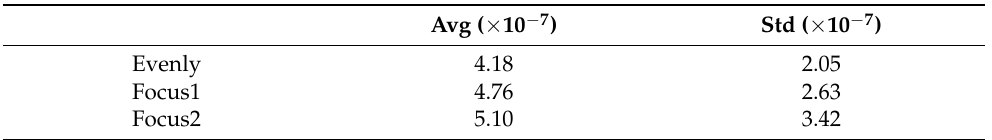
Figure 5. Sensitivity distribution of ( a ) uniform electrode array, ( b ) optimized array1 and ( c ) opti- mized array2. Table 1. Comparison of mean and standard deviation of sensitivity distributions of the heart region under the three models shown in Figure 4.